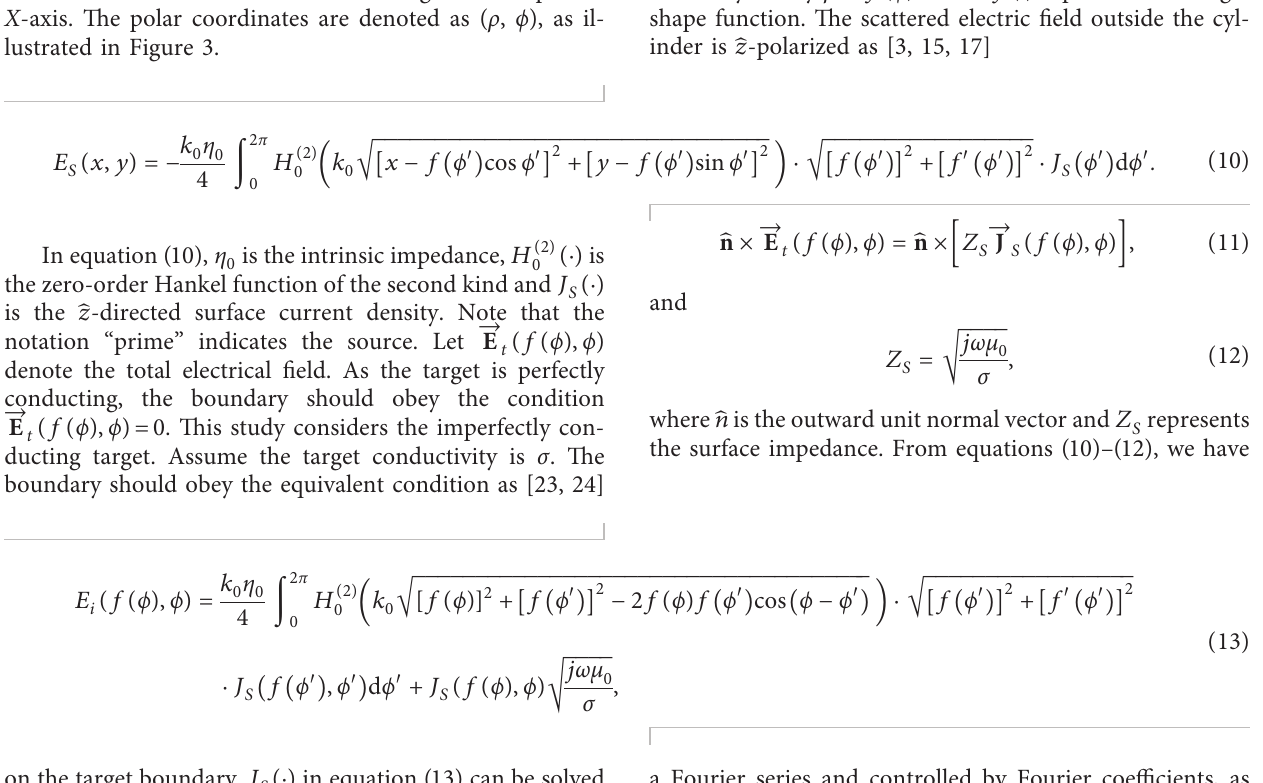
→ ( x, y ) � E ( x, y ) 􏽢 z i i